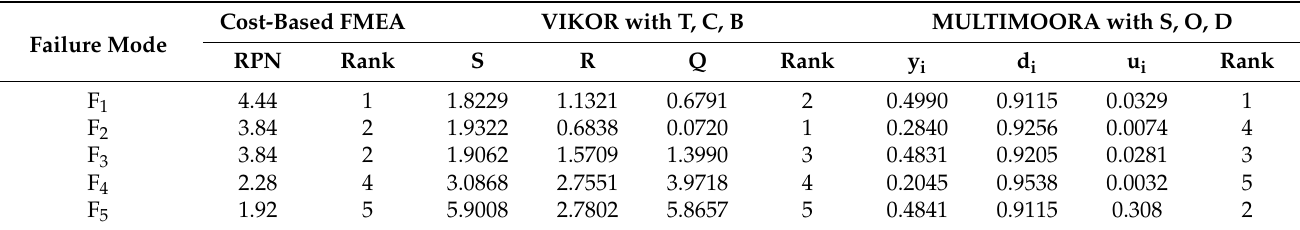
Table 9. The results of